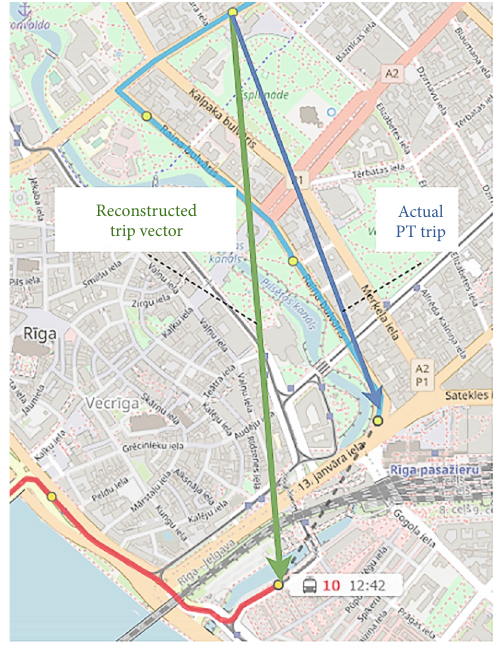
Figure 1. Illustration of a difference between actual and reconstructed PT trip vectors (the actual vector is presented in blue, the reconstructed one – in